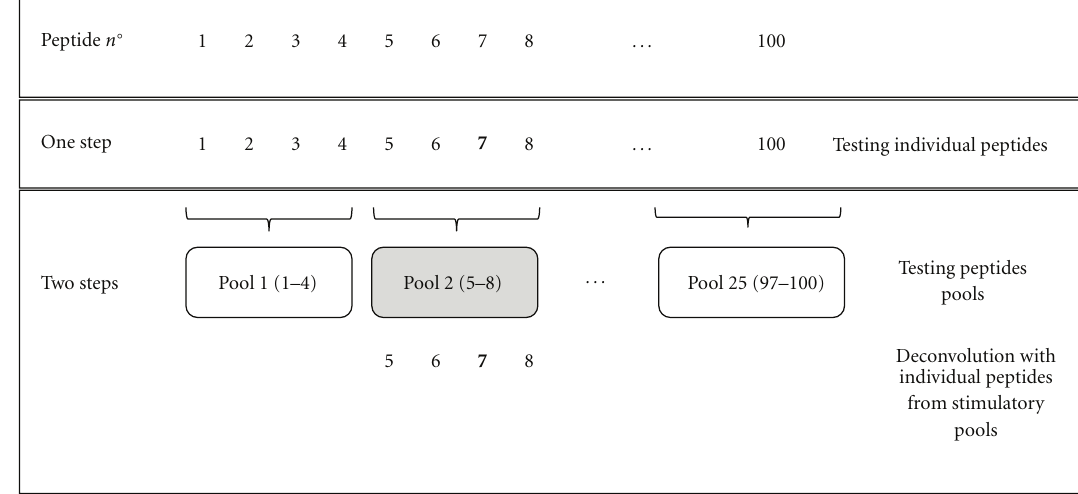
Figure 1: Conventional layout of peptide panels for T epitope mapping. In this example of a panel of 100 peptides, peptides can be tested individually in one step or as pools in two steps. Peptide 7 in bold represents the immunodominant peptide. Response to a positive pool can be further deconvoluted by testing the individual peptides encompassed by the stimulatory pool. The one step approach is simpler, but it requires more cells. The two-step approach requires fewer cells, but cells are needed at two di ff erent times. Thus, the cases in which a small fraction of pools are positive can take advantage of this approach, while in the worst case, in which the majority of the pools are positive and need to be individually deconvoluted, the two-step approach provides no significant